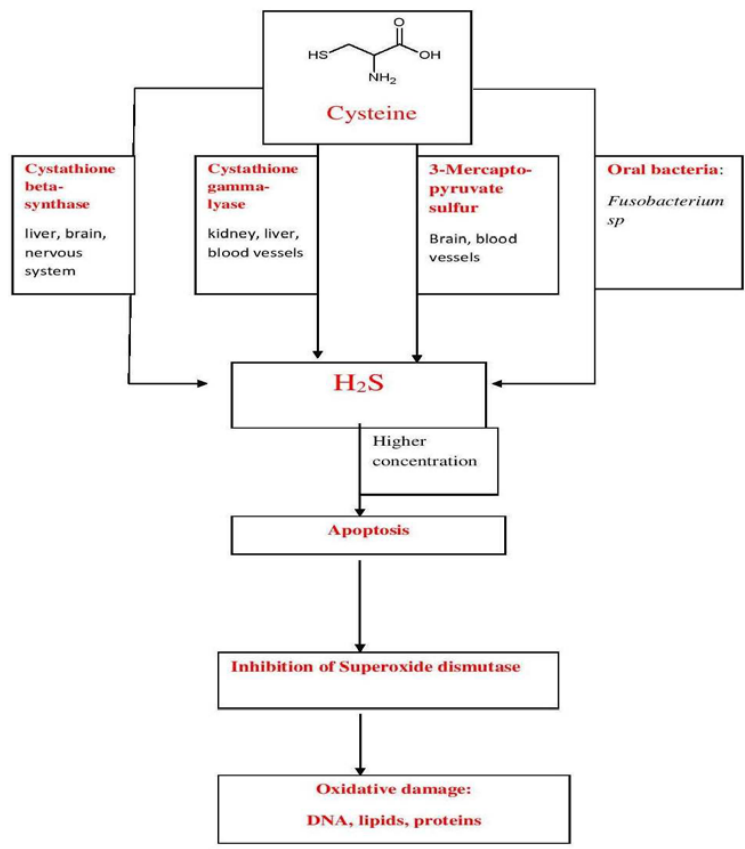
Figure 1. Hydrogen sulfide production—Cysteine biosynthesis pathway is the main pathway